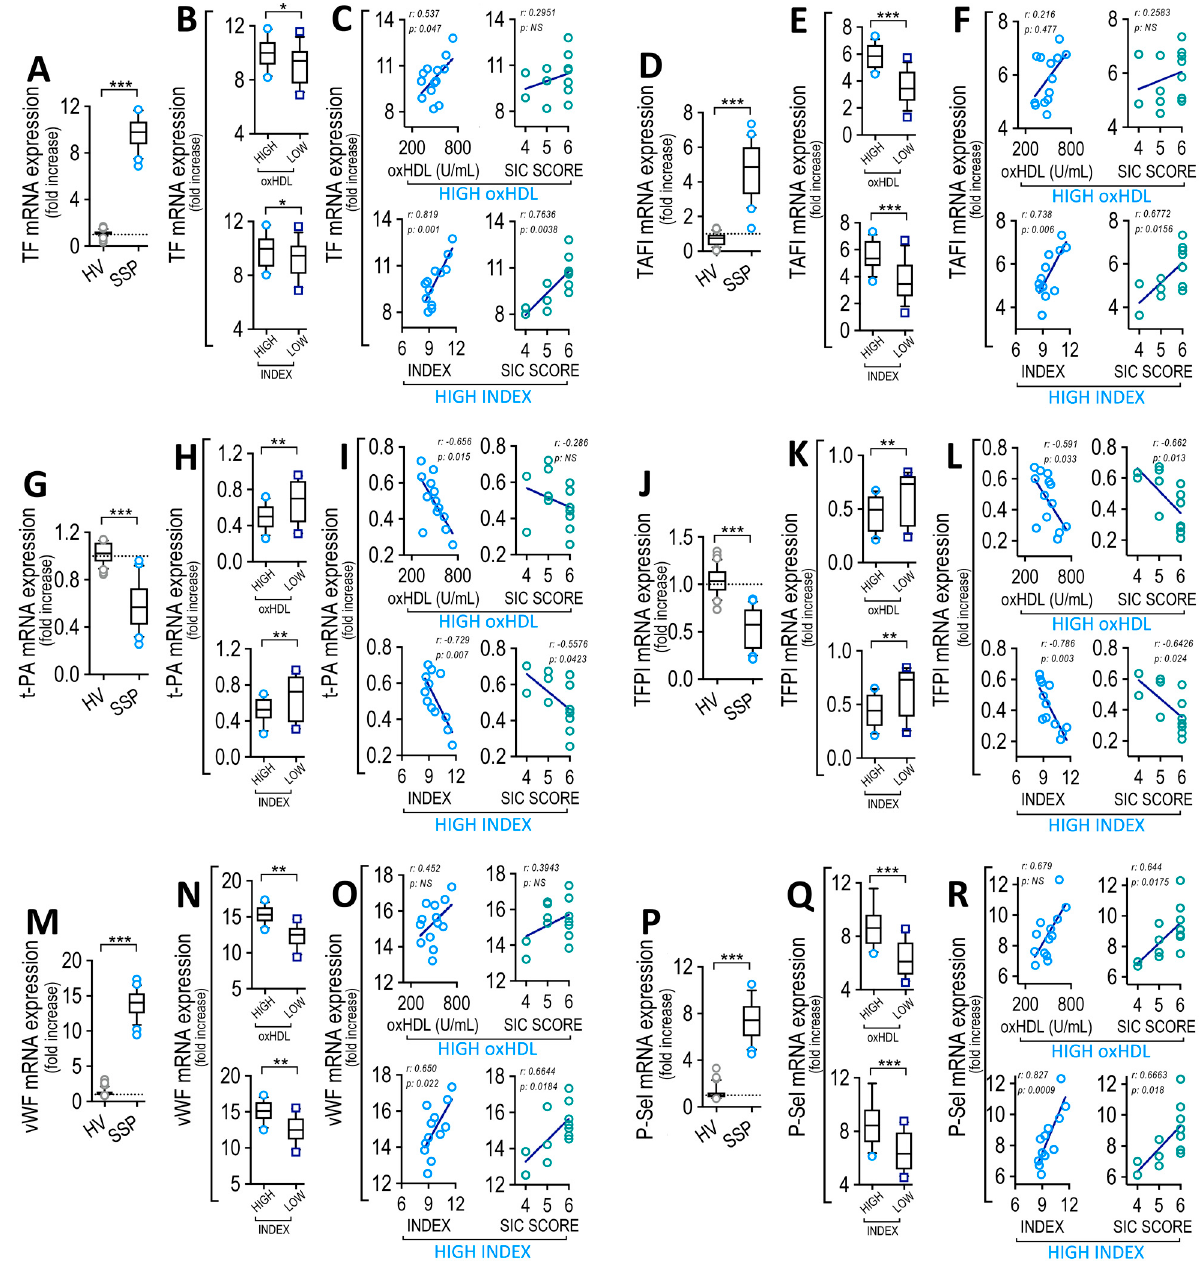
Figure 7. Coagulation factors and platelet adhesion proteins expression in cultured EC exposed to plasma from SSP. Plasma samples were collected from HV, high-oxHDL and low-oxHDL SSP blood samples and then added to cultured EC for 24 h. Normalized mRNA expression of TF ( A ), TAFI ( D ), t-PA ( G ), TFPI ( J ), svWF ( M ) and sP-Sel ( P ) in HV and SSP. Plasma level of TF ( B ), TAFI ( E ), t-PA ( H ), TFPI ( K ), svWF ( N ) and sP-Sel ( Q ) in high- and low-oxHDL and high- and low-INDEX groups from SSP. Statistical differences were assessed with student’s t-test (Mann–Whitney). * p < 0.05, ** p < 0.01, *** p < 0.001. Values are expressed as the median ± 10–90 percentile. Correlation analyses between: TP with high-oxHDL ( C , left panel, r = 0.537; p = 0.047), SIC score from high-oxHDL ( C , middle-left panel, r = 0.2951; p = 0.3277), high-INDEX ( C , middle-right panel, r = 0.819; p = 0.001) and SIC score from high-INDEX (( C ), right panel, r = 0.7636; p = 0.0038), TAFI with high-oxHDL (( F ), left panel, r = 0.2168; p = 0.477), SIC score from high-oxHDL (( F ), middle-left panel, r = 0.2583; p = 0.3943), high-INDEX (( F ), middle-right panel, r = 0.738; p = 0.006) and SIC score from high-INDEX (F, right panel, r = 0.6772; p = 0.0156), t-PA with high-oxHDL (( I ), left panel, r = − 0.656; p = 0.015), SIC